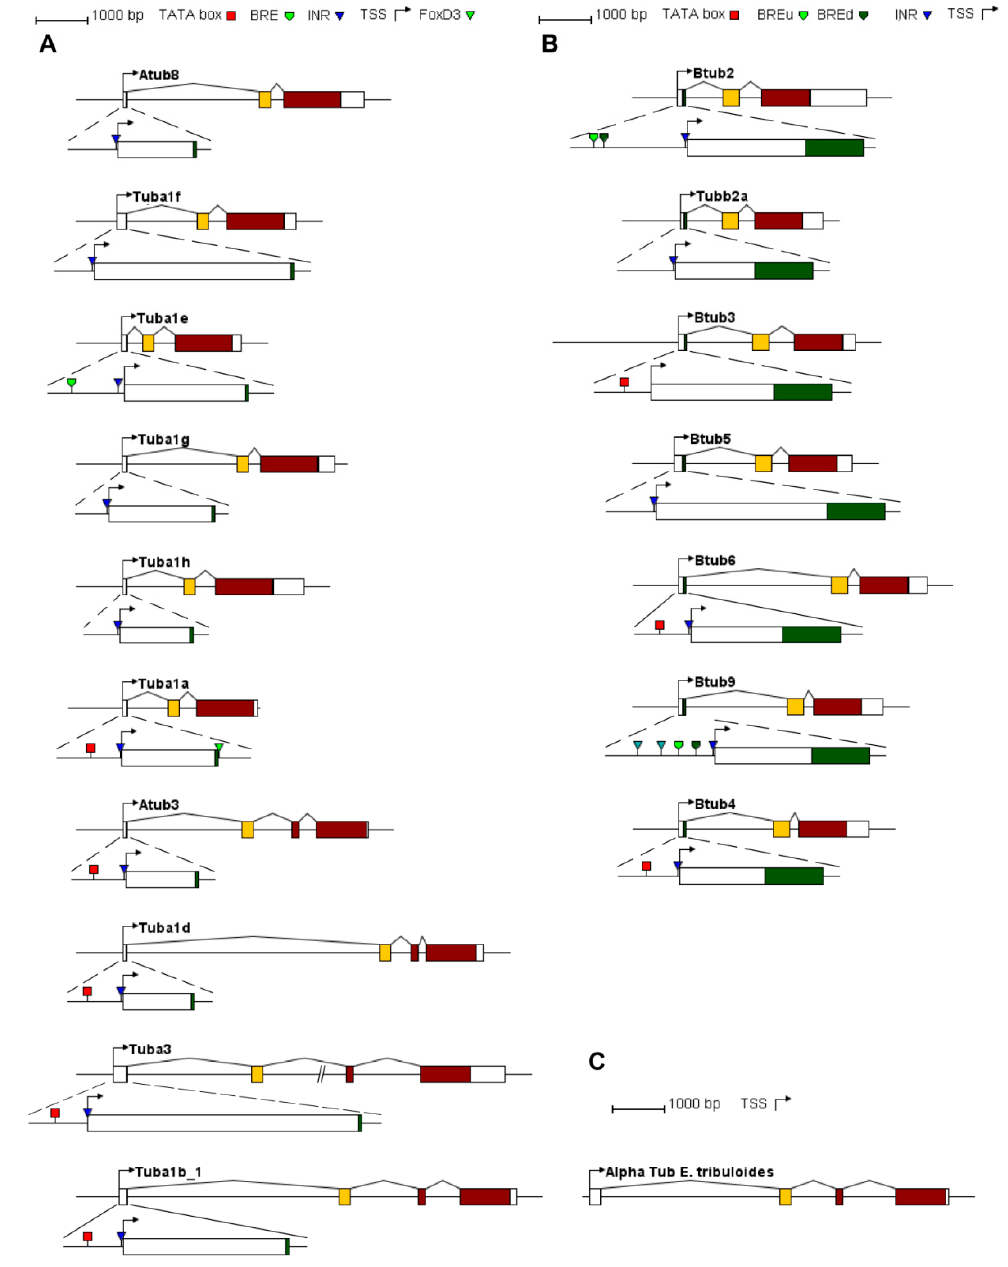
Figure 3. α - and β -tubulin gene structure and core promoter analysis. Schematic gene structures of the Paracentrotus lividus α -tubulins ( A ), β -tubulins ( B ) and an α -tubulin gene of Eucidaris tribuloides ( C ), drawn to scale. The bent arrows indicate the putative transcription start sites (TSS). Boxes represent exons. In particular, white boxes indicate untranslated regions and coding regions are coloured. Core promoter elements are shown as indicated. Table 2. Tubulin genes: core promoter elements and expression analysis during development.